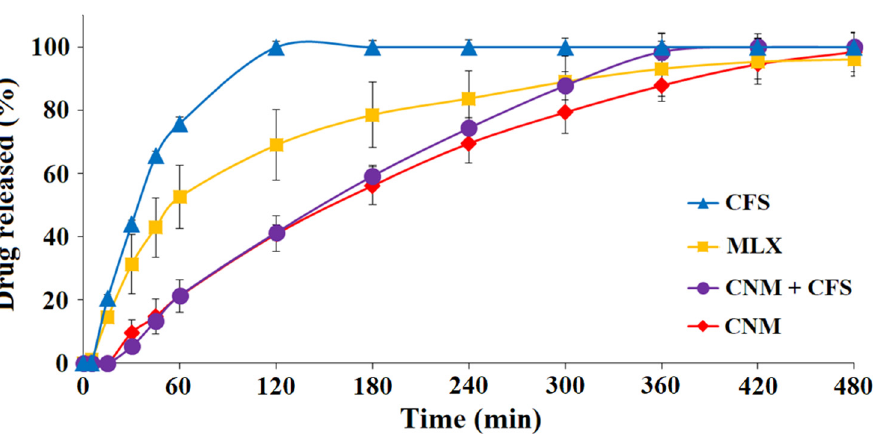
Figure 5. Release profiles of multiparticulate colonic systems of 0.35–1.50 mm diameter size (CNM, CFS and CNM + CFS) and pure MLX in pH 6.8 medium.